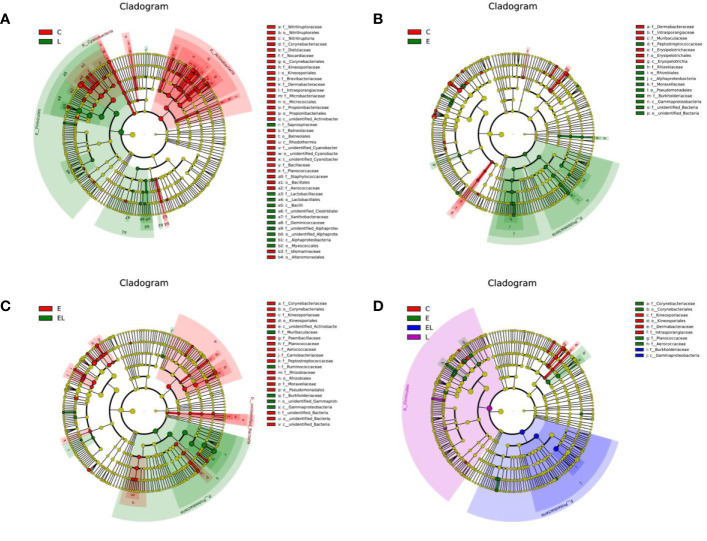
Differentially abundant phylotypes in different groups on the basis of LEfSe analysis. Cladogram obtained from LEfSe analysis displayed the different taxa in microbiota of different groups of mice. (A) Cladogram indicating the phylogenetic distribution of microbiota correlated with the C and L groups. (B) Cladogram indicating the phylogenetic distribution of microbiota correlated with the C and E groups. (C) Cladogram indicating the phylogenetic distribution of microbiota correlated with the E and EL groups. (D) Cladogram indicating the phylogenetic distribution of microbiota correlated with the C, E, EL and L groups. The colored circles from the inside to the outside represent different taxonomic levels (phylum, class, order, family, and genus levels). The yellow circles in the cladogram indicate the taxa with no evident differences.